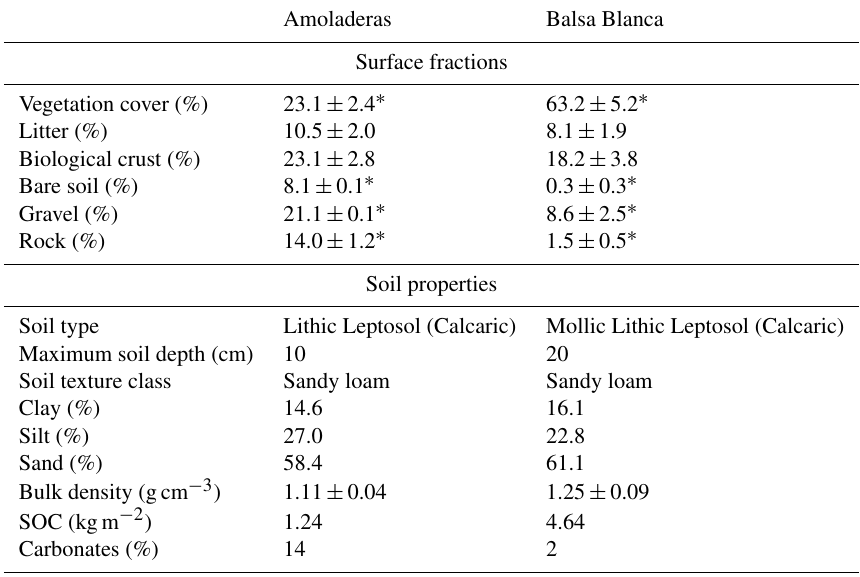
Table 1. Site characteristics, surface fractions and soil properties of both experimental sites studied. Asterisks denote significant differences ( p -value < 0.05). Adapted from Rey et al.